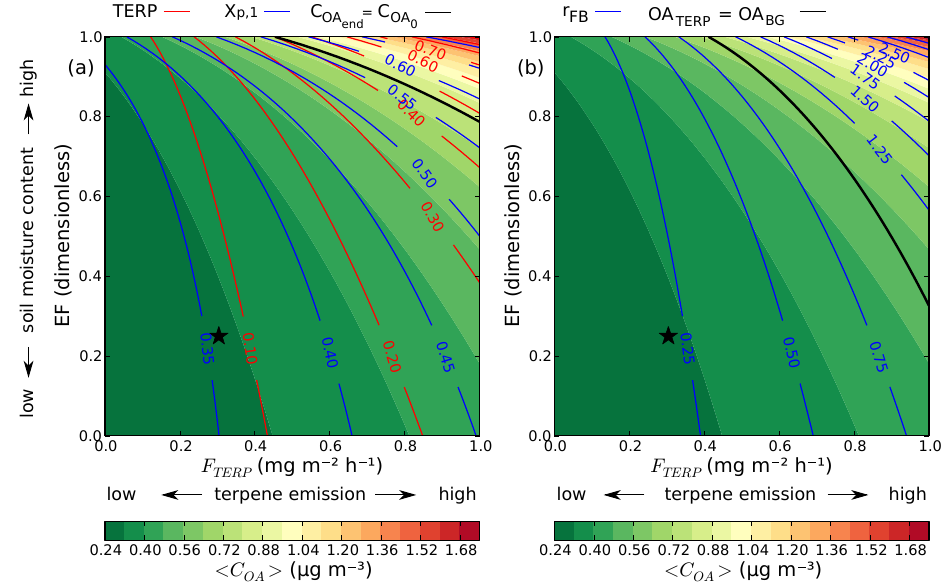
Fig. 9. (a) Sensitivity of organic aerosol concentration C OA and TERP concentration at 18:50LT to terpene emission ( F TERP ) and evaporative fraction (EF). Shades indicate organic aerosol concentration C OA (µgm − 3 ), the red contours the TERP concentration (µgm − 3 ), and the blue contours the partitioning coefficient X p, 1 . The black line indicates the conditions for which the C OA at the end of the day equals the initial concentration, and the asterisk indicates the conditions for the case study. (b) Sensitivity of organic aerosol concentration C OA and the OA chemistry background ratio r FB at 18:50LT to F TERP and EF. Shades indicate C OA (µgm − 3 ) and the blue contours r FB . The black line indicates the conditions for which the C OA consists of equal parts of OA TERP and OA BG ( r FB = 1), and the asterisk indicates the conditions for the case study.